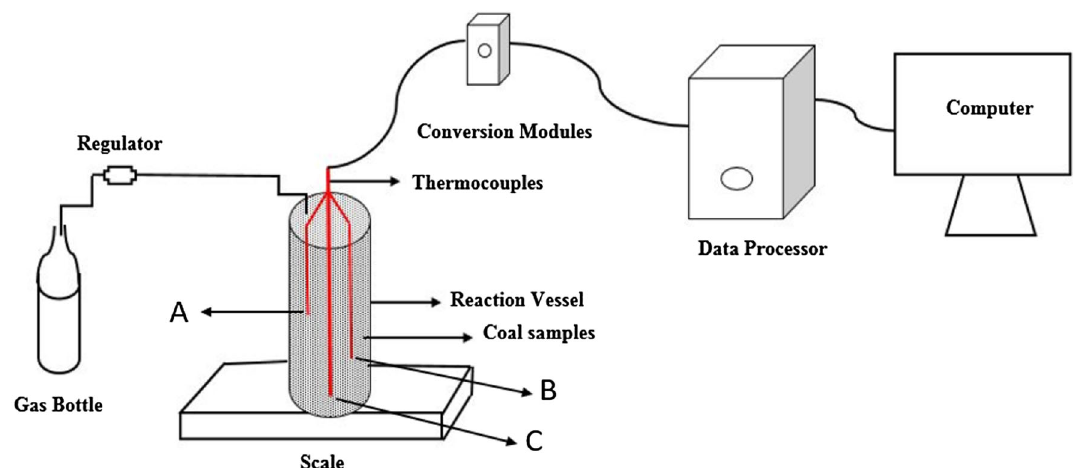
Fig. 4 Wits-CT apparatus (Onifade et